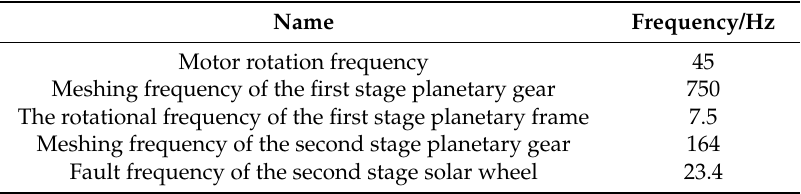
Table 1. Components of vibration signals and their corresponding frequencies.